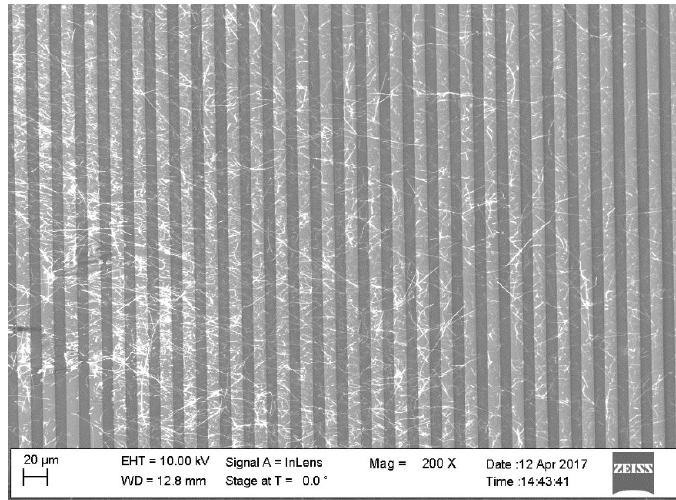
Figure 2. Part of the Au-IDES structure with many SnO 2 -NWs in parallel forming the sensing